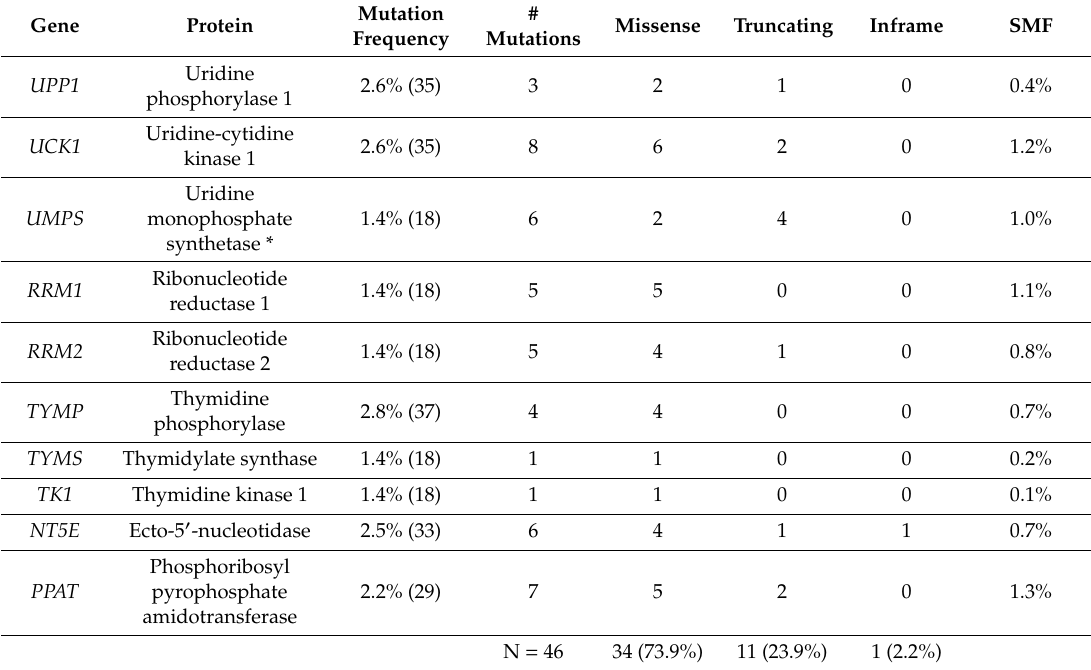
Table 2. We analyzed the main components of the 5FU conversion system, among 6 studies comprising 1365 patients regarding GC; SMF: somatic mutation